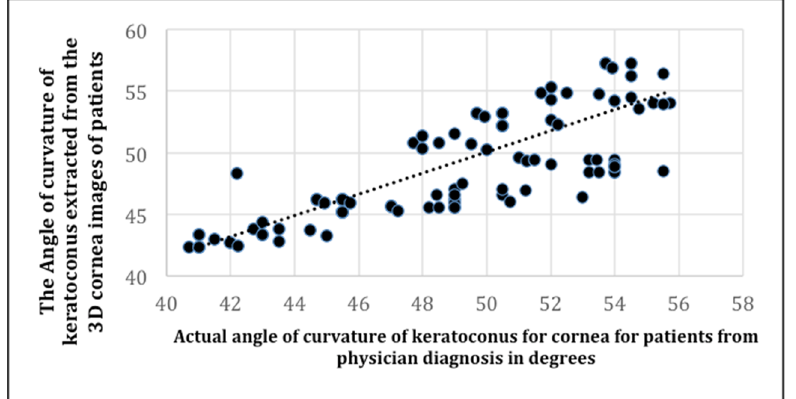
Figure 10. The correlation between the actual angle of curvature of keratoconus in patients, and the angle of curvature of keratoconus extracted from 3D corneal images of the patients.